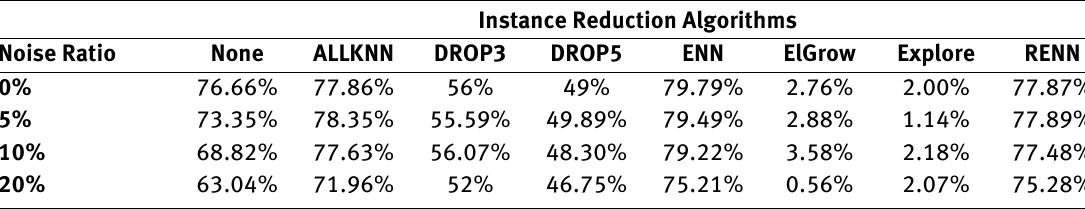
Table 14: Average classification accuracy for pruned trees at different noise ratios